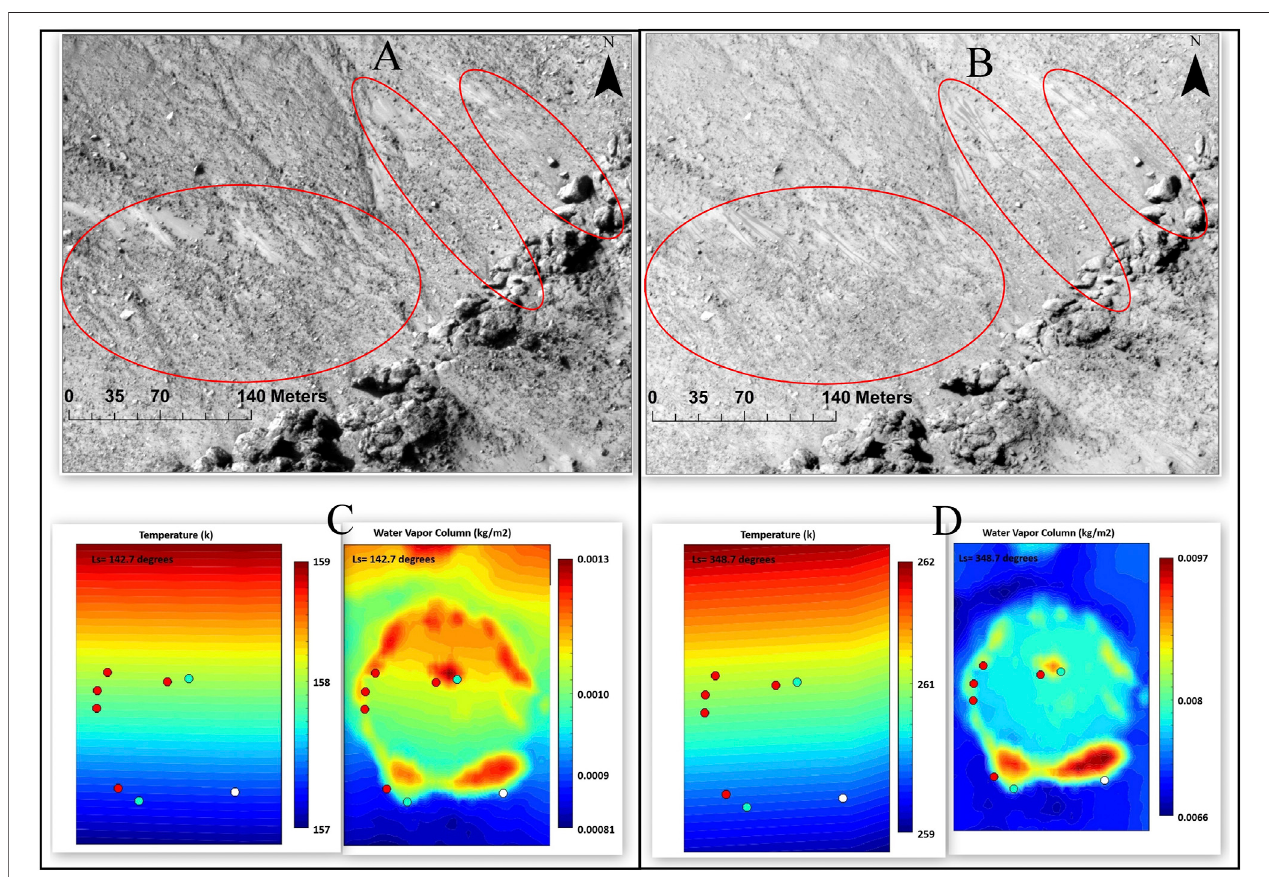
FIGURE 6 | (A) and (B) are HiRISE data of Asimov crater at Ls 142.7 ° and Ls 348.7 ° to see RSL variation in the image, whereas (C) and (D) are the associated atmospheric parameters acting at the same time of HiRISE data acquisition on the surface of